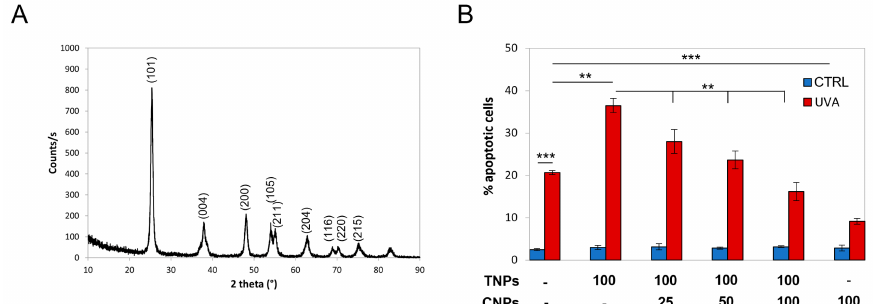
Figure 4. Nanotitania increases UVA-cytotoxicity, which is prevented by nanoceria. ( A ) XRD diffrac- tion pattern and Miller indexes of nanotitania (TNPs). ( B ) Nanoceria (CNPs) dose-dependently reduce apoptosis induced by UVA-irradiated TNPs-induced apoptosis. HaCaT cells were exposed to UVA ± nanoparticles as described (concentration indicates µ g/mL). The fraction of apoptotic cells is quantified by nuclear morphology as described. Statistical significance was calculated via Student’s t -test. ** p < 0.01 and *** p <